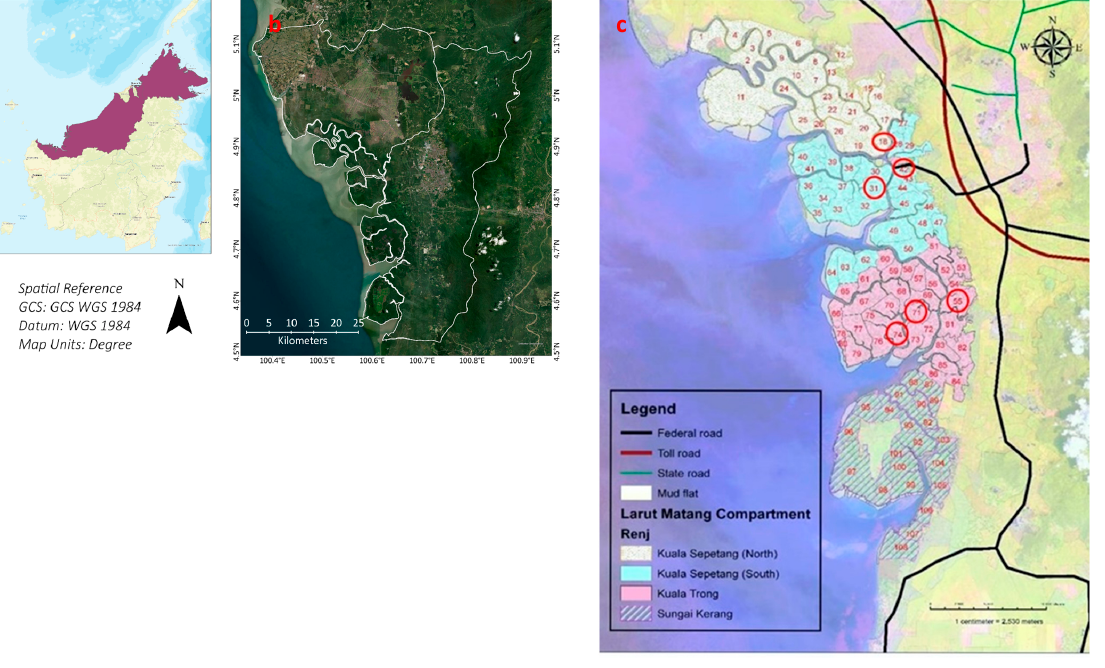
Figure 8. ( a ) A map of Malaysia with the Matang area and Perak state, ( b ) the MMFR and state of Perak, and ( c ) encircled sampling